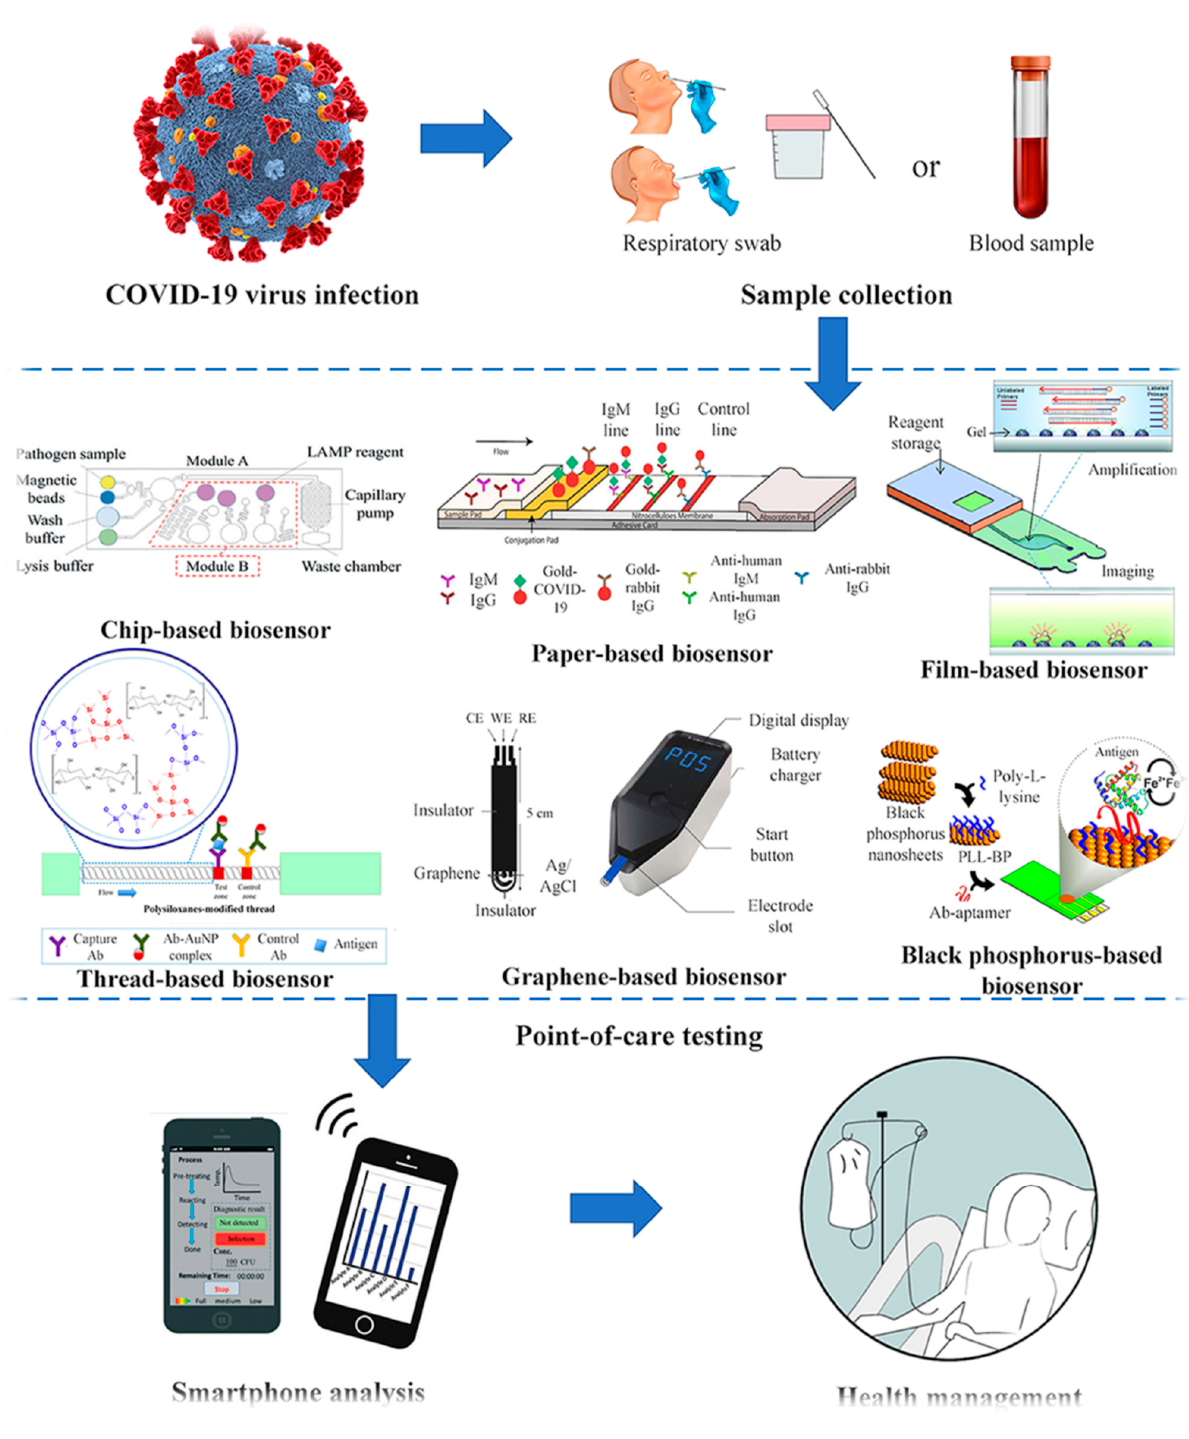
Figure 3. Point-of-care biosensors for detection of COVID-19. Reprinted with the permission of Ref. [107]. Copyright 2020, Frontiers.